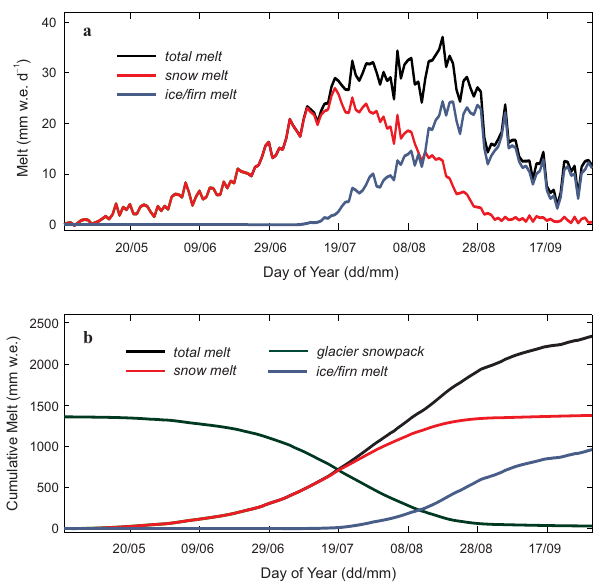
Figure 8. Daily and cumulative run-off from Haig Glacier, 1 May– 30 September, based on average daily values from 2002 to 2013. (a) Snowmelt (red), ice and firn melt (blue), and total melt (black), mmw.e.d − 1 . (b) Cumulative snow, ice/firn, and total meltwater, along with the mean glacier snowpack (green), mmw.e. All values are glacier-averaged.